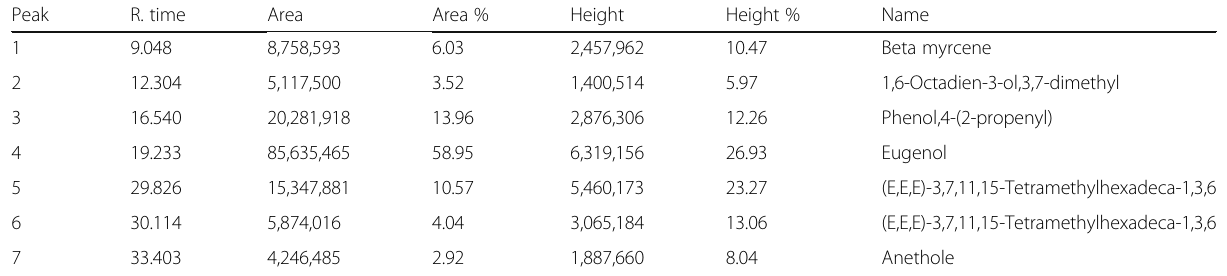
Table 4 GC-MS analysis of bay essential oil revealing the abundance of certain compounds Peak R. time Area